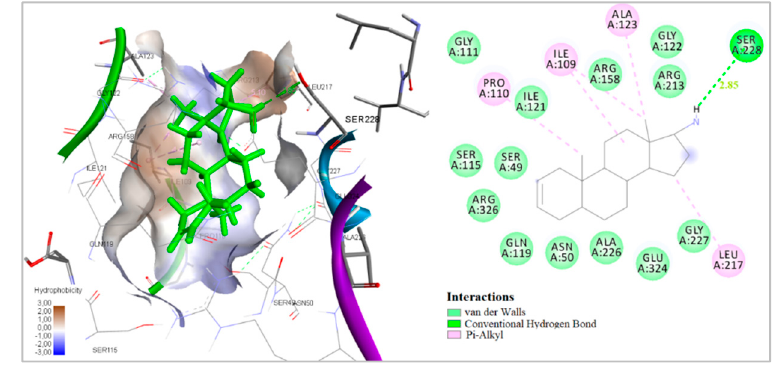
Figure 1. Docked conformation of the most active compound 19 in E. coli MurB.